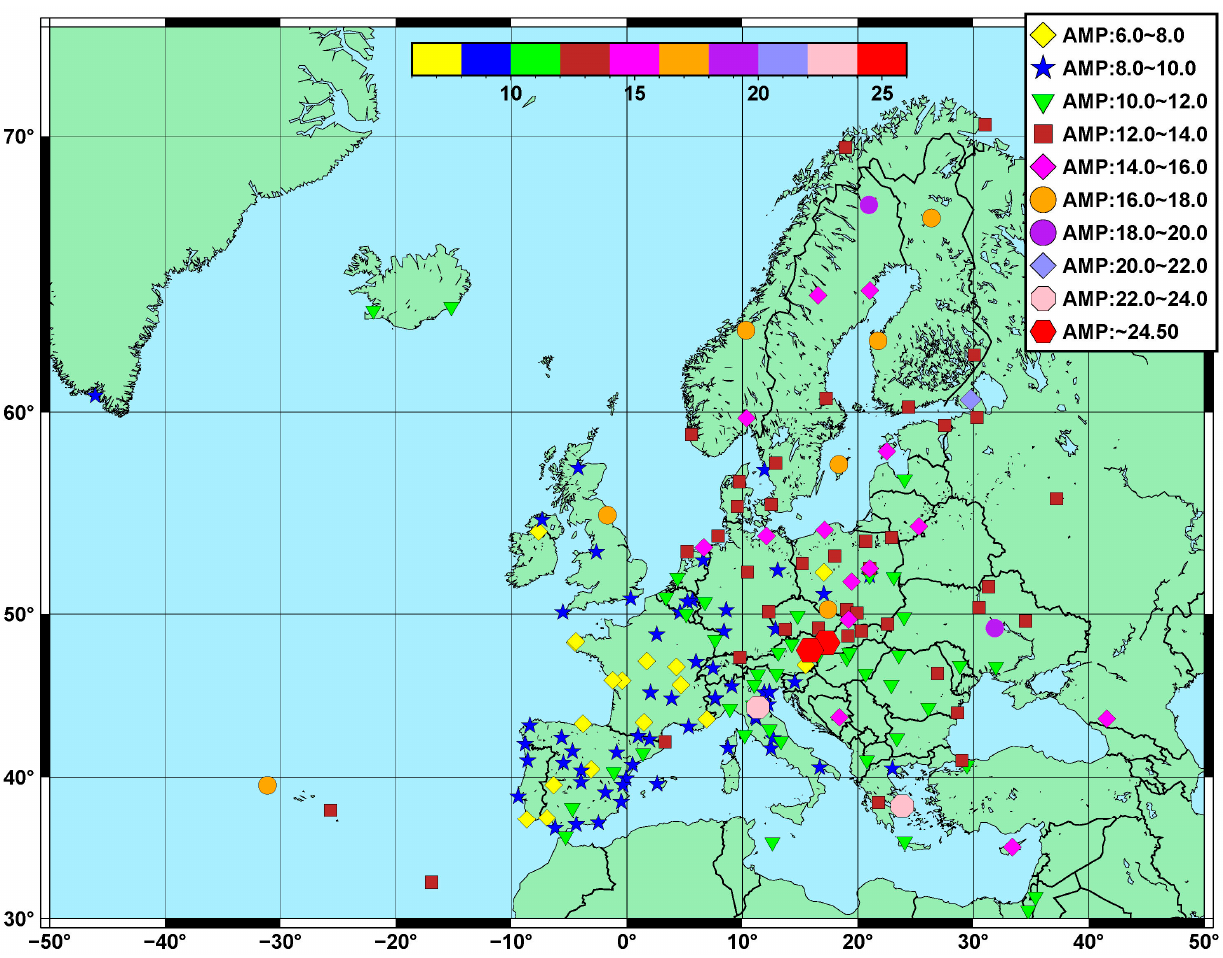
Figure 7. Noise amplitude for the Up component.